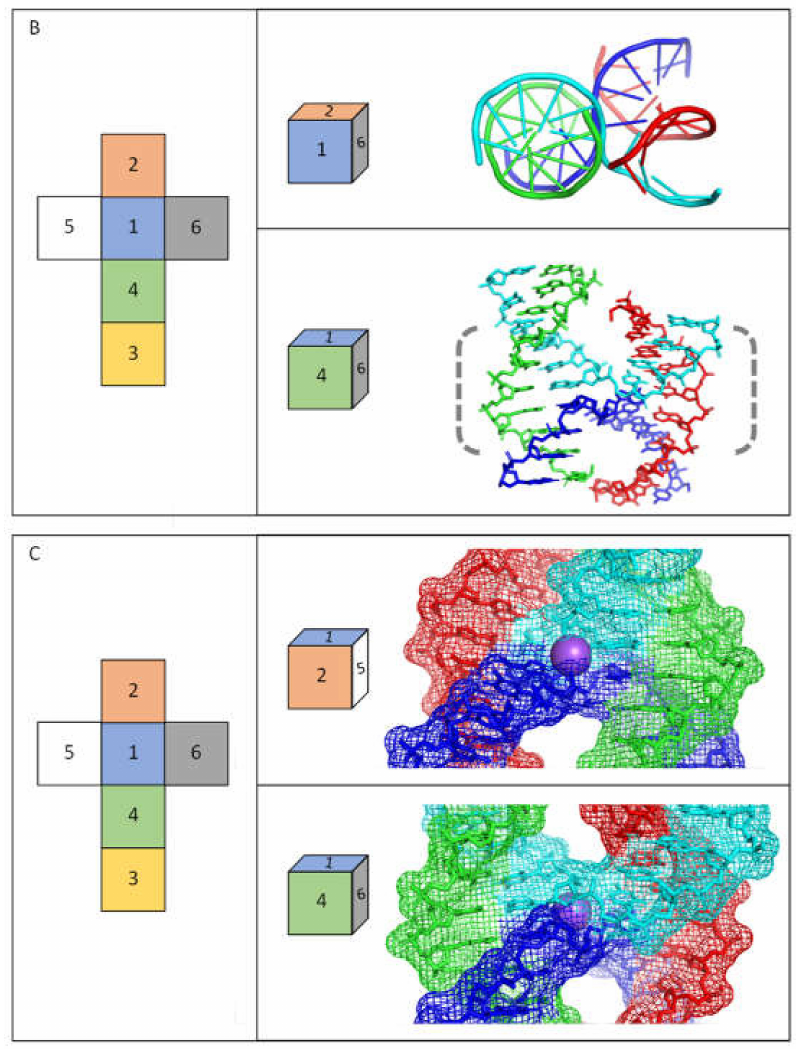
Figure 2. High-resolution structure of a cruciform (four-way junction) formed by an inverted repeat DNA sequence. Images show the X-ray crystallographic structure determined at 2.10 Å for DNA with the sequence 5 (cid:48) -CCGGTACCGG-3 (cid:48) (1DCW) [37]. The DNA alone forms a four-way junction in a stacked-X conformation, in which duplexes coaxially stack, with each pair of stacked duplexes related by +30 ◦ to +60 ◦ (right-handed) rotation. The continuous (least distorted relative to B-DNA) strands are coloured as green and red, while those of the crossing strands (making a tight U-turn) are coloured blue and cyan. In each panel, the images show the structure visualised via different axes viewpoints as indicated by the coloured squares. ( A ) The upper image provides a schematic view of the molecule, the distinct strands (in different colours), and their sequences, with arrows indicating the 3 (cid:48) -ends of the DNA strands. The lower image presents the high-resolution structure of 1DCW, illustrating its arrangement of base pairs. ( B ) The upper image views the structure down the helix axis of one pair of stacked duplexes, while the lower image views it from a rotational shift of approximately 90 ◦ . ( C ) The images zoom in on the central part of the structure (dashed bracketed region in ( B )) to highlight the electrostatic interactions, particularly close to the Na + ion at its centre. The lower image views the same face of the dyad axis shown in ( B ), and the upper image shows the opposite face of the axis, viewed from a rotational shift of approximately 180 ◦